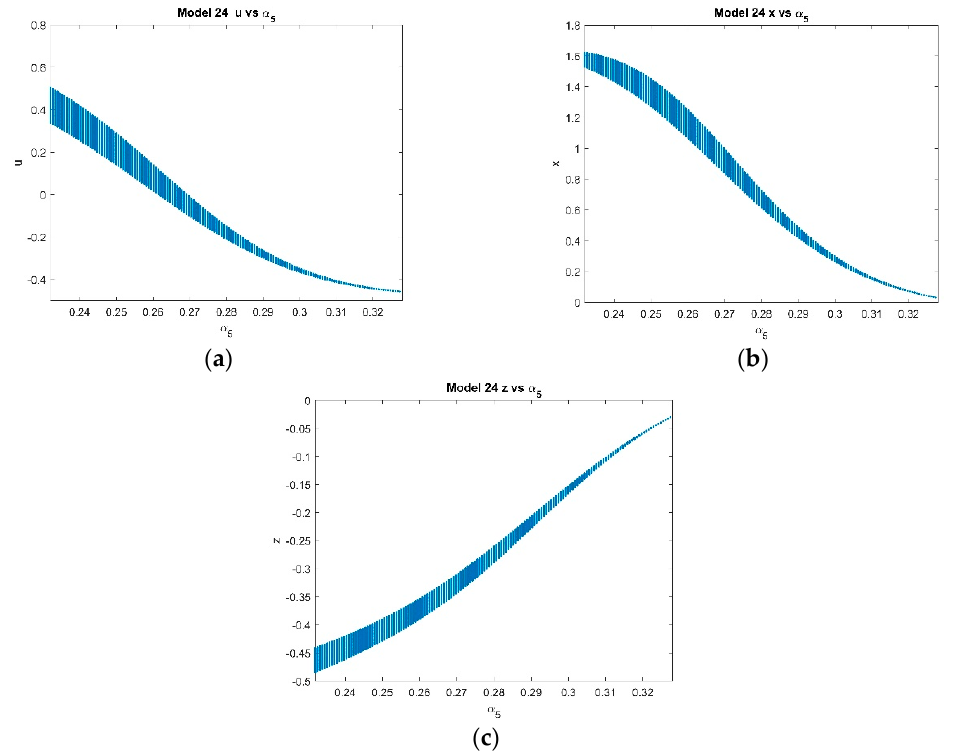
Figure 7. ESDDFD model (24); ( a ) u vs. α 5 , ( b ) x vs. α 5 , ( c ) z vs. α 5 , at k = 2, p = 1, α 5 ∈ [ 0.232, 0.328 ]